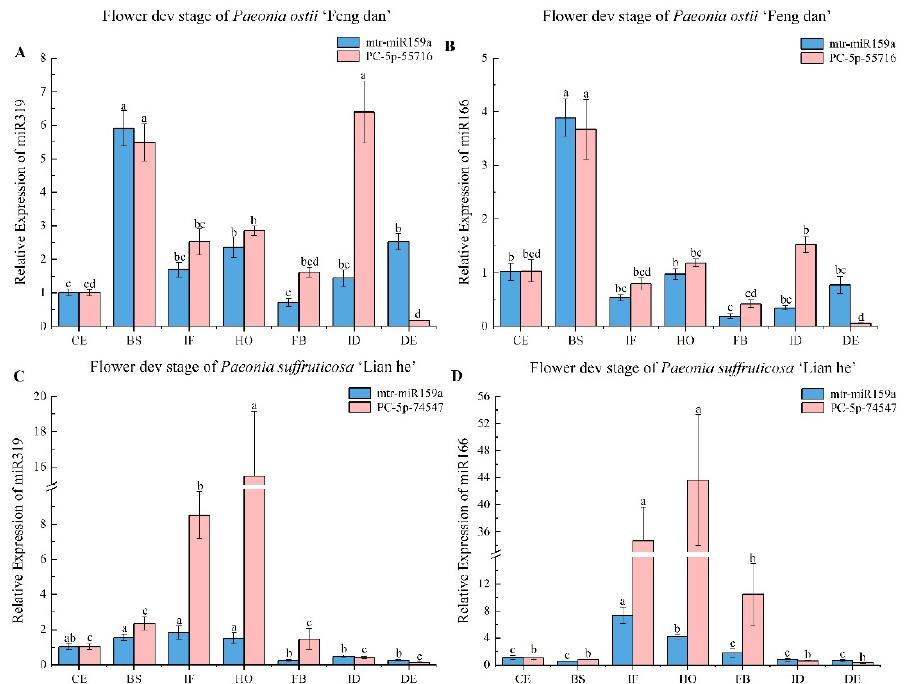
Figure 10. Performance evaluation of miR319 ( A , C ) and miR166 ( B , D ) expression standardization in flower development stage using reference miRNAs. CE: Color-exposure stage; BS: Blooming stage; IF: Initial flowering stage; HO: Half opening stage; FB: Full blooming stage; ID: Initial decay stage; DE: Decay stage. The legend represents the internal reference used in calculating relative expression amount. Different lowercase letters represent significant differences ( p < 0.05). Error bars are standard error of mean (SEM).